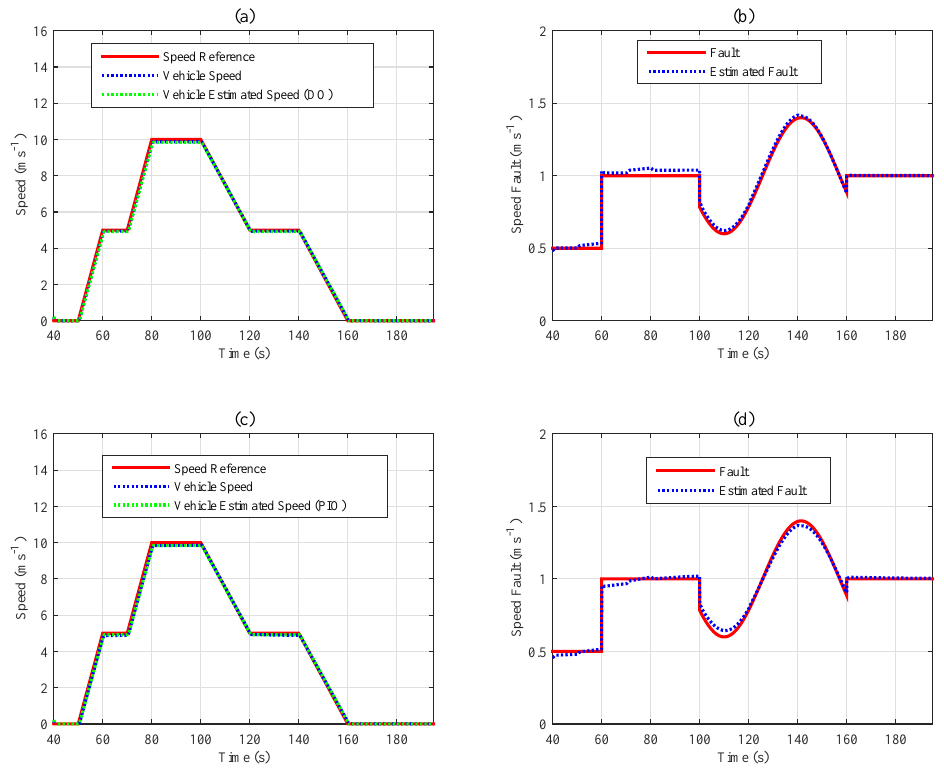
Figure 16. Speed profile( ( a ) with descriptor observer, ( c ) with proportional and integral observer) and fault estimations ( ( b ) with descriptor observer, ( d ) with proportional and integral observer) of the simulated closed-loop FTC